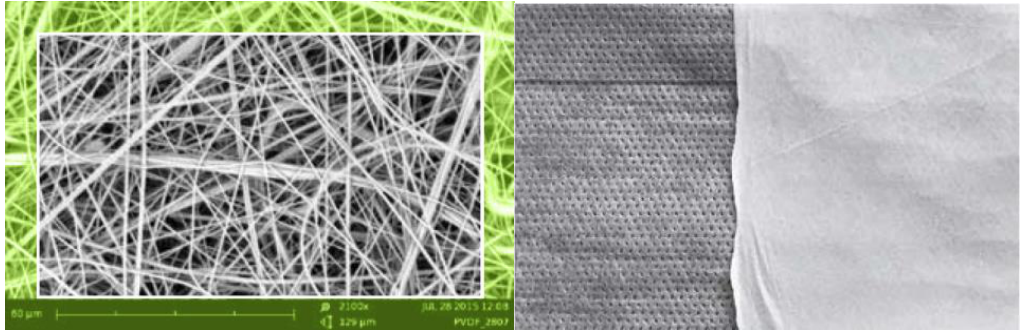
Figure 3. SEM image PVDF nanofibers, magnification 2100× ( left ), PVDF nanomembrane on the PP meltblowen support ( right ).